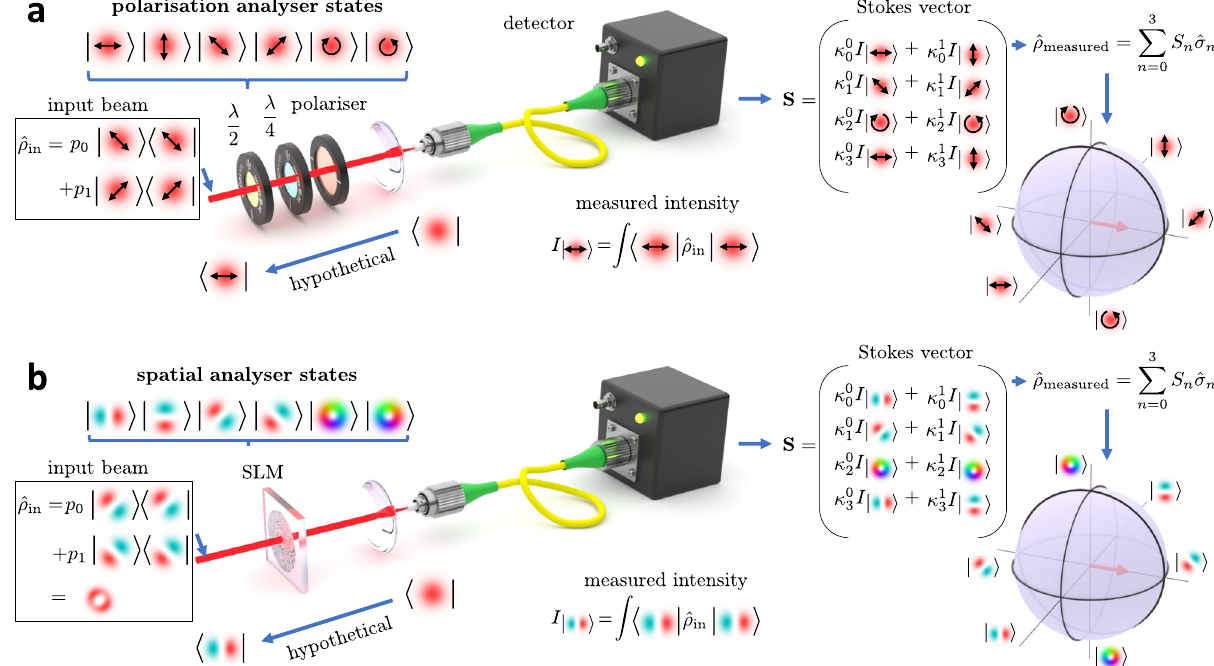
, passes through in